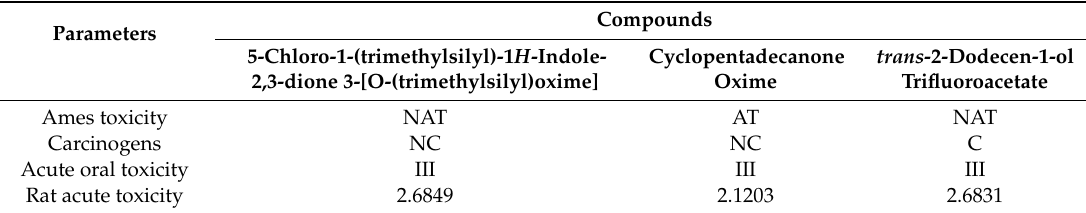
Table 9. Toxicological properties of the selected compounds in